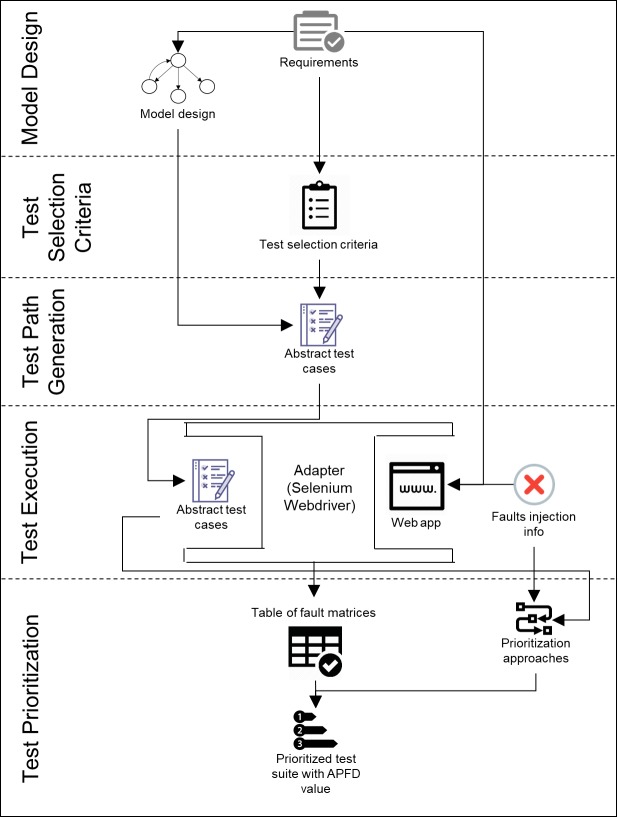
Experiment design.